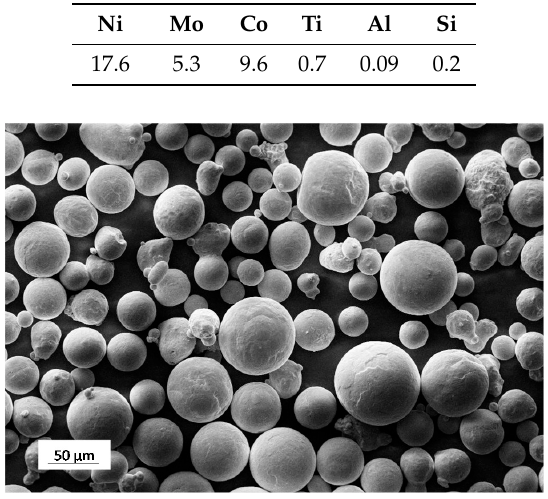
Figure 1. View of the 18 ‐ Ni 300 alloy powder investigated.